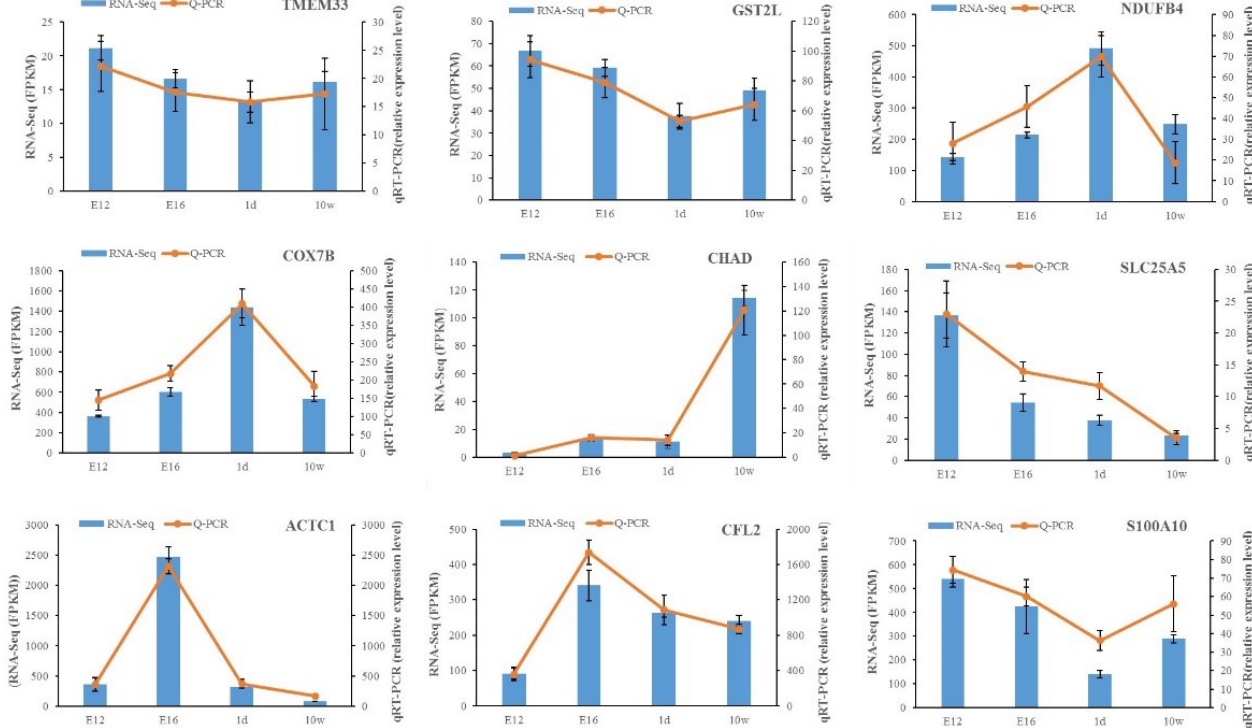
Figure 3. Expression levels of nine DEGs detected by RNA-Seq and validated by qPCR. The results from RNA-Seq are shown in bar graphs, and the FPKM values are shown on the right y axis. The results from qPCR are shown in line graphs, and relative expression values are shown on the left y axis. The data are presented as the mean ±